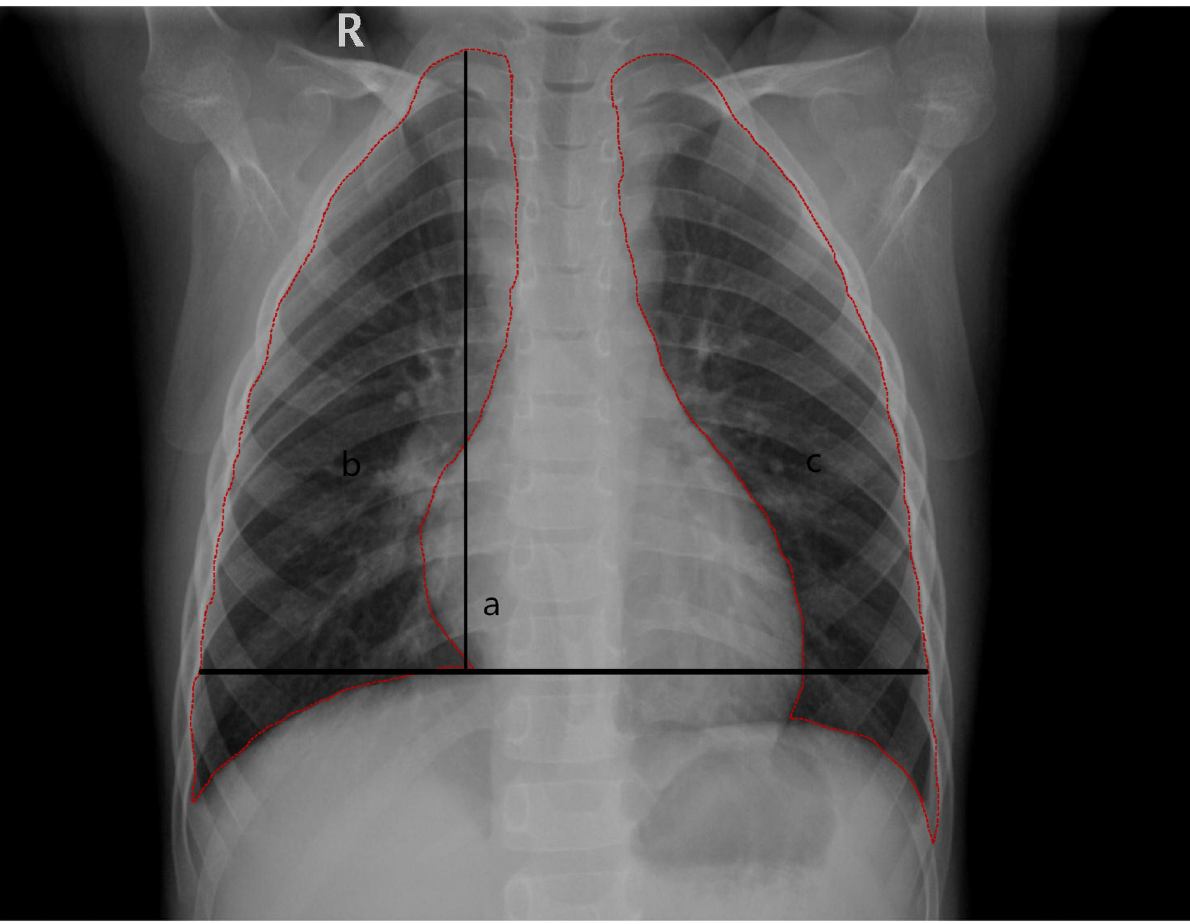
Fig 2. Schematic diagram showing LD and LFA measurements in a chest DR image of a pediatric participant. The subject is a 45-month-old female. In the figure, a represents the LD from the apex of the right lung to the apex of the right diaphragm, b represents the right LFA obtained by measuring the area within the closed curve drawn along the right lung field and the mediastinal margin, and c represents the left LFA obtained by measuring the area within the closed curve drawn along the left lung field and the mediastinal margin. The sum of b and c represents the entire LFA of the